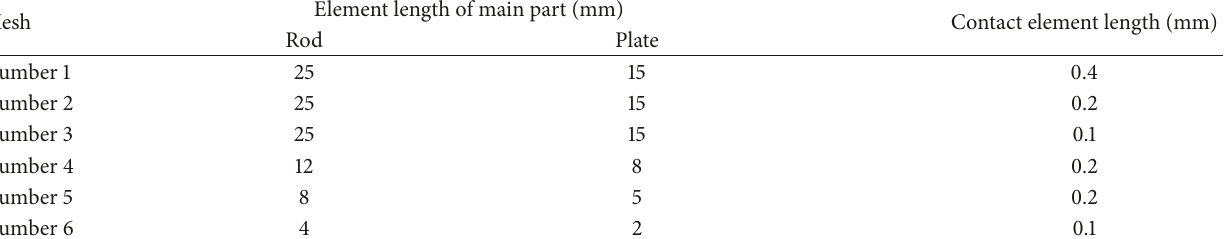
Table 2: Element length of meshes 1–6.